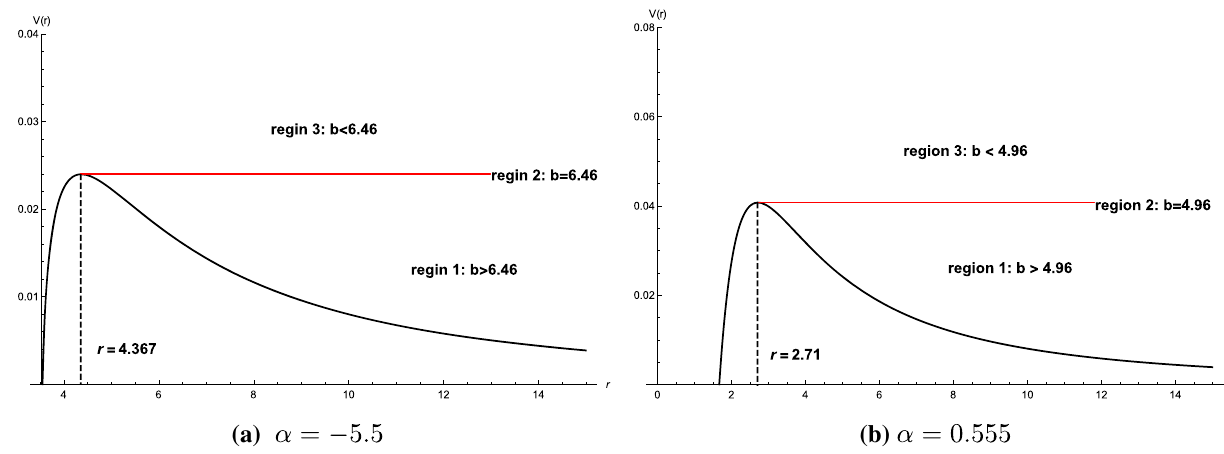
Fig. 1 The profiles of the effective potential for α = − 5 . 5 (left panel) and α = 0 . 555 (right panel) with M = 1. For both panels, Region 2 corresponds to the red lines where V ( r ) = 1 / b 2